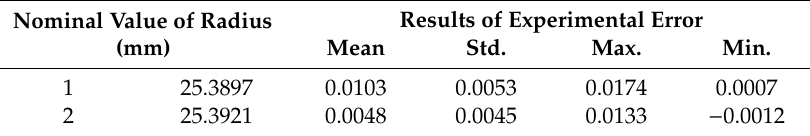
Figure 7. Reconstructing the spherical crown and fitting spheres in 12 di ff erent places. Table 1. Results of precision experiment. Std, standard deviation.